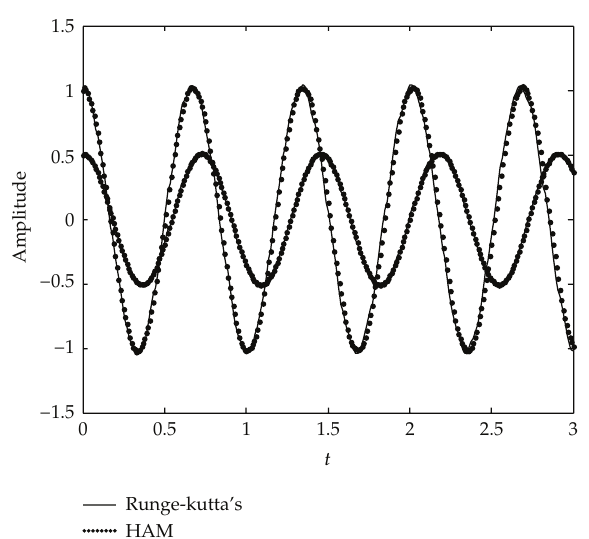
Figure 2: Variation of the nondimensional amplitude of the beam center versus t .